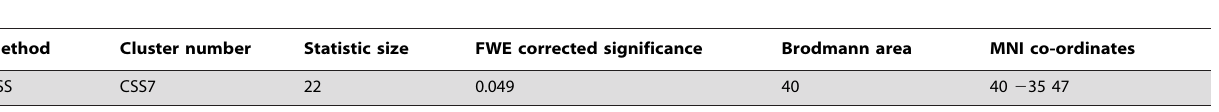
Table 2. Increases in connectivity.